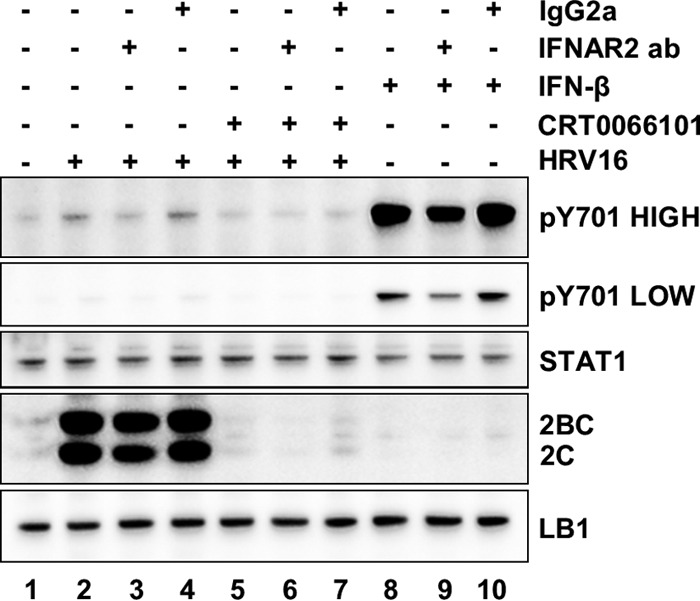
Effect of blocking of type I interferon receptor signaling on CRT0066101. In order to determine if a blockade of the type I interferon receptor (IFNAR2) influenced the ability of CRT0066101 to inhibit viral replication, HeLa cells were left untreated (lane 1) or pretreated with DMSO (lanes 2 to 4) or 5 μM CRT0066101 (lane 5 to 7) for 1 h. Cells were subsequently infected with HRV16 for 1 h (lanes 2 to 7), and replication was allowed to proceed for a further 4 h. During the viral infection and replication periods, cells were treated with a blocking antibody to IFNAR2 alone (lane 3) or with an isotype-matched control antibody alone (lane 4) or cotreated with CRT0066101 and a blocking antibody (lane 6) or CRT0066101 with an isotype control (lane 7). As additional controls, cells were treated with 30 U/ml of IFN-β for 4 h (lanes 8 to 10), with no antibody (lane 8), with anti-IFNAR2 (lane 9), or with an isotype control antibody (lane 10). Cell extracts were prepared and analyzed by Western blotting with antibodies to pSTAT1 Y701, STAT1, HRV 2C, and LB1. The pSTAT1 Y701 blot is shown at high and low exposures, and data shown are from a representative experiment from three independent repeats.